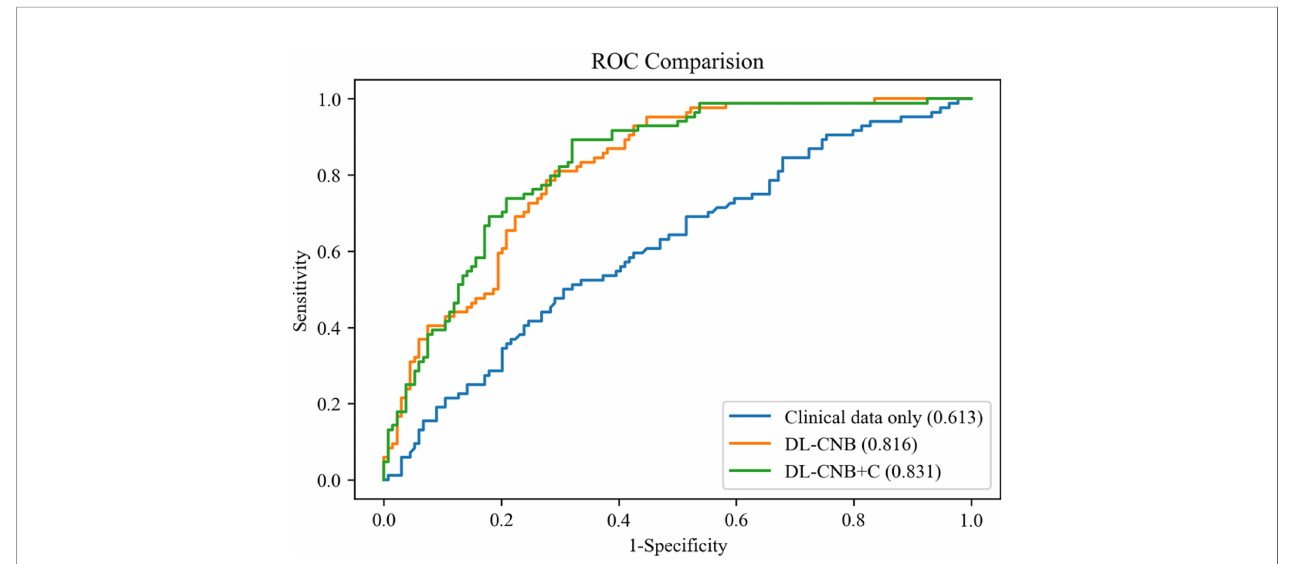
FIGURE 4 | Comparison of receiver operating characteristic (ROC) curves between different models for predicting disease-free axilla (N0) and heavy metastatic burden of axillary disease (N(+)). Numbers in parentheses are areas under the receiver operating characteristic curve (AUCs).